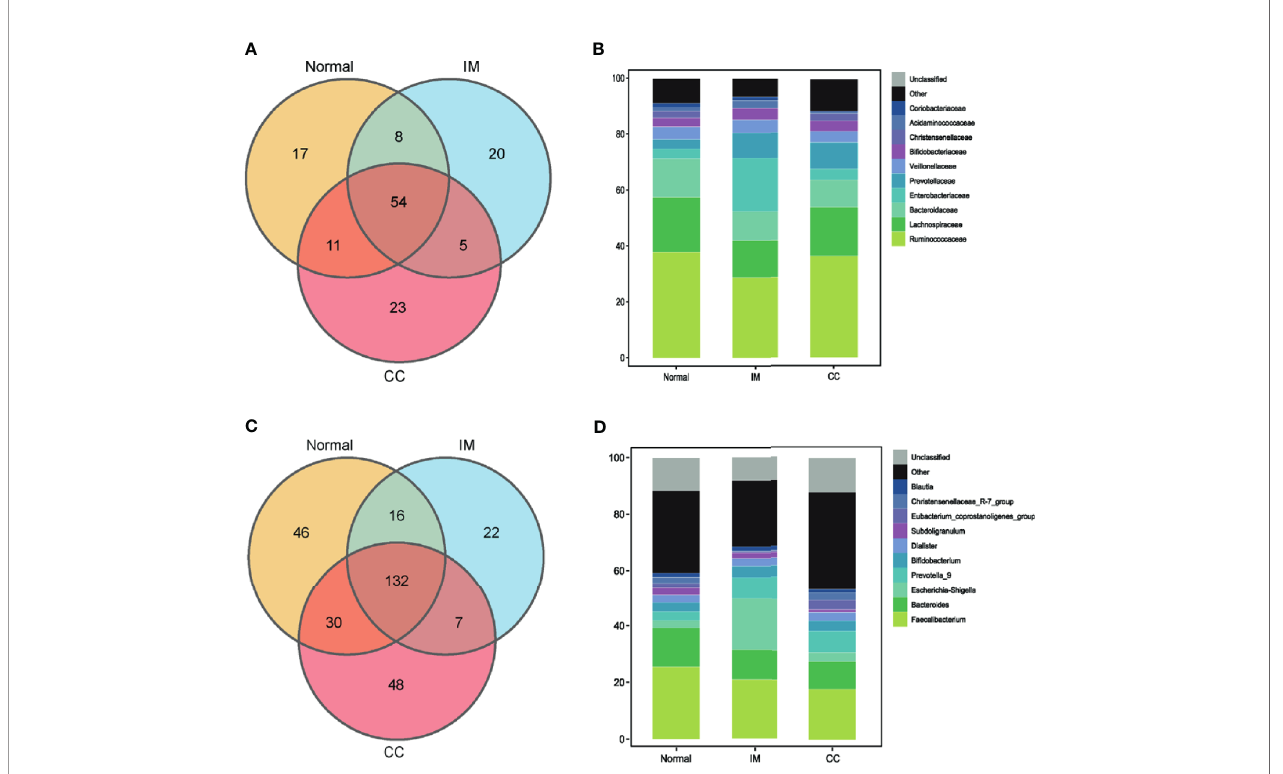
FIGURE 3 | Bacterial populations and dominant microbiome in fecal samples. (A) Families in each group were examined for common and unique family using a Venn diagram. Overlapping areas represent common family between groups. (B) A cylindrical accumulation map at the family level. The relative abundance of the 10 most abundant bacteria in subjects. (C) Genus in each group were examined for common and unique genus using a Venn diagram. Overlapping areas represent common genus between different groups. (D) A cylindrical accumulation map at the genus level. The relative abundance of the 10 most abundant bacteria in